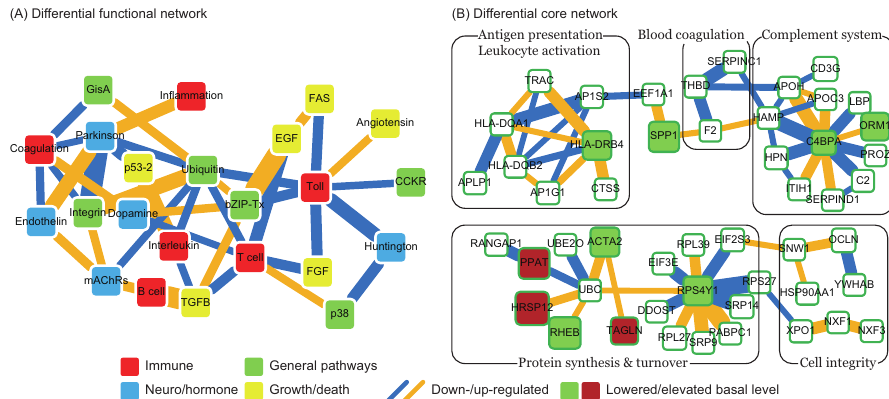
Figure 2. Differential functional and core networks from Stage I to II. ( A ) Differential functional network. Node colors indicate the biological significance of the enriched functions. Red: immune; blue: neuro/hormone; green: general pathway; yellow: growth/death. Link colors indicate changes in interaction ability from Stage I to II. Blue: down-regulated; orange: up-regulated. Link width indicates the absolute value of the difference in interaction ability from Stage I to II; ( B ) Differential core network. Node colors indicate changes in basal level, representing changes in miRNA and methylation regulations from Stage I to II. Green: lowered; red: elevated. Link colors indicate changes in interaction ability from Stage I to II. Blue: down-regulated; orange: up-regulated. Link width indicates the absolute value of the difference in interaction ability from Stage I to